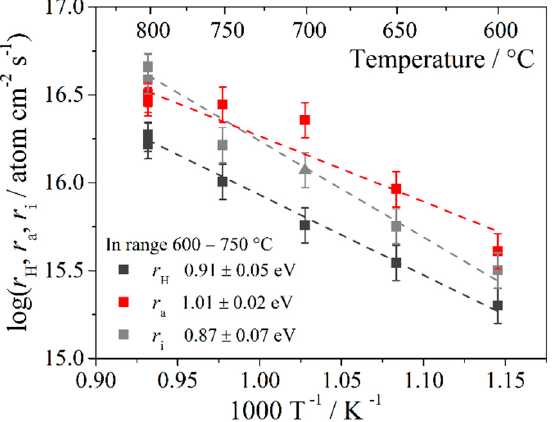
Figure 4. Temperature dependence of the oxygen heterogeneous exchange rate ( r H ), oxygen adsorption rate ( r a ), and oxygen incorporation rate ( r i ) of Sr 2 Fe 1.5 Mo 0.5 O 6 −δ oxide at P o 2 = 10 − 2 atm.